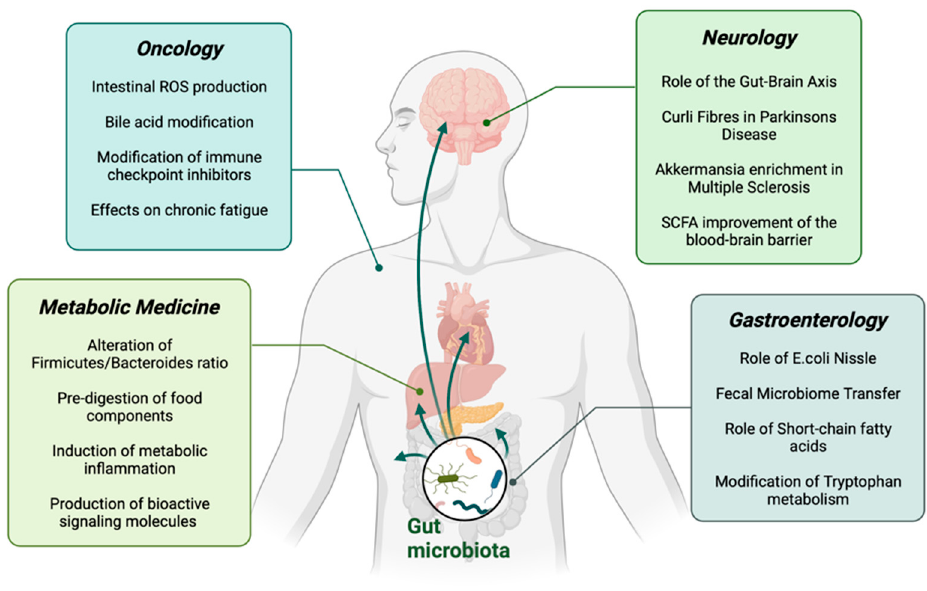
Figure 1. Schematic overview of the main topics in this review. SCFA: Short-Chain Fatty acids.